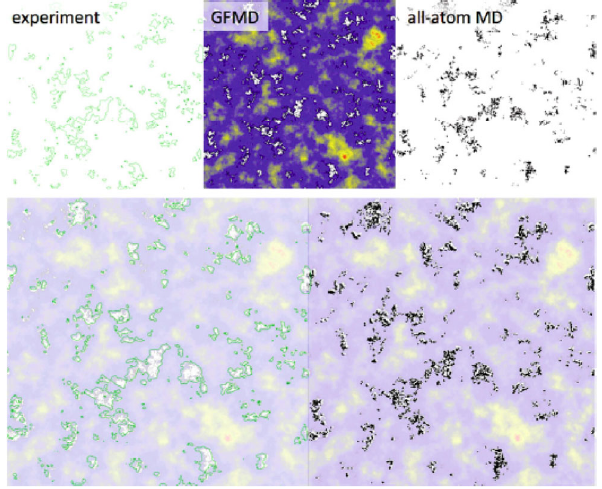
Fig. 28 Comparison of contact patterns. The upper left panel shows the experimentally measured contact area, the center top panel shows a gap distribution obtained from GFMD, and upper right panel shows atoms in contact as obtained by all-atom MD. The lower row shows the superposition of GFMF with experi- ment (left) and with all-atom simulation (right). Reproduced with permission from Ref. [638]. © Springer Science Business Media, LLC,